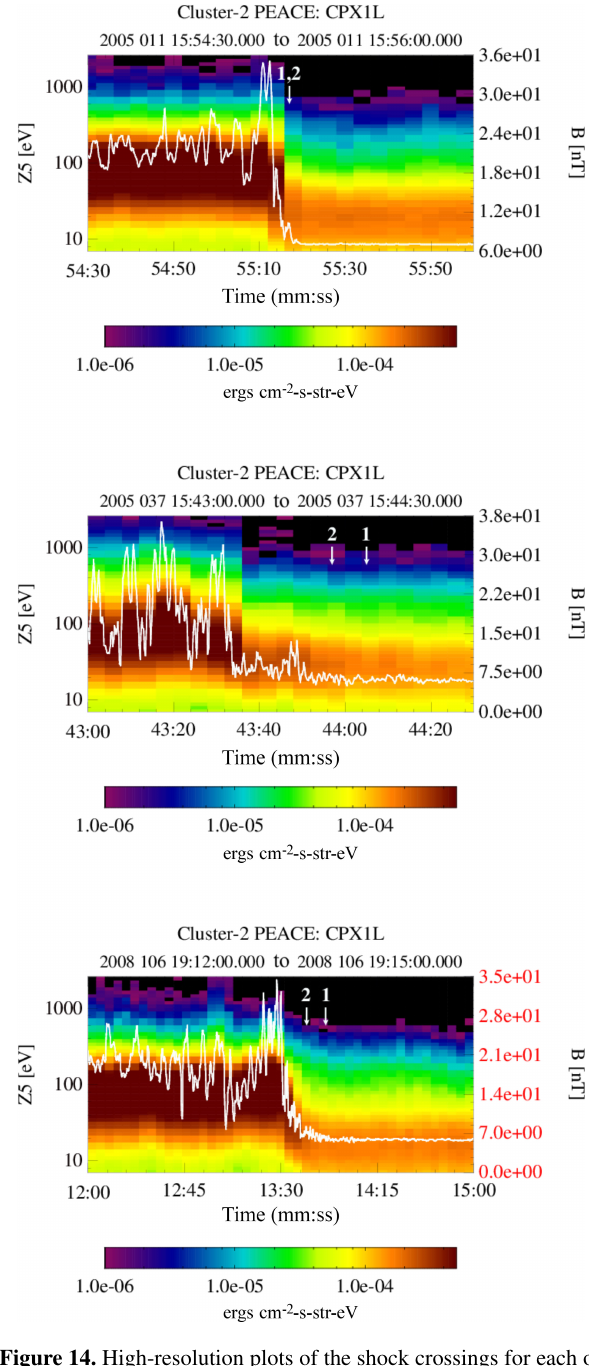
Figure 14. High-resolution plots of the shock crossings for each of the three events. Each plot contains a spectrogram of the PEACE elevation Zone 5 sensor overlaid by the magnetic field. The spectro- gram has a one-spin resolution and the magnetic field resolution is 0.2s. There are two numbered arrows in each plot. Arrow 1 is the point at which the strahl disappears from the φ – θ plots and arrow 2 is where the return electron signature disappears. The location of the arrows is somewhat subjective, especially for arrow